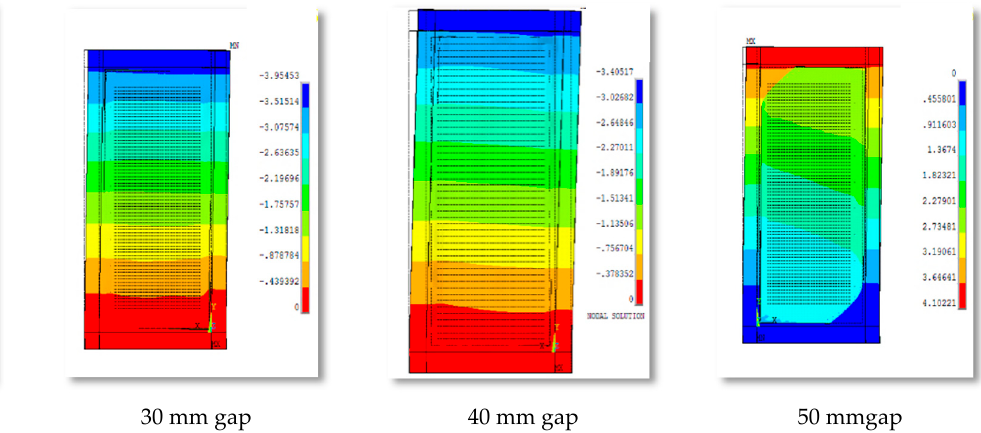
Figure 9. Lateral displacement of group 1.